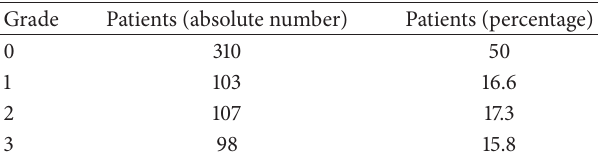
Table 1: Prevalence of facet joint (FJ)